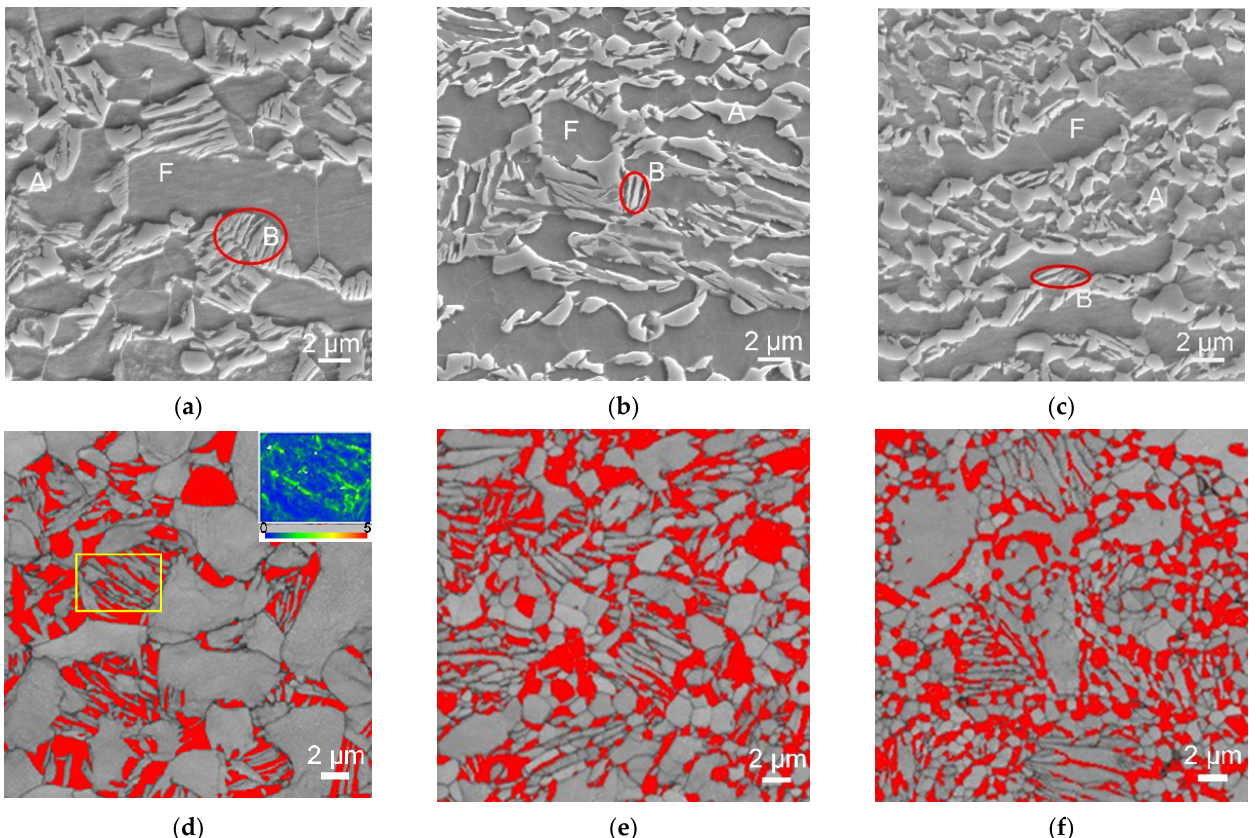
Figure 4. The microstructure observation by scanning electron microscope (SEM) ( a – c ) and electron backscattered diffraction (EBSD) ( d – f ) on three experimental steels treated by process 2. ( a , d ) 1 Mn steel; ( b , e ) 1.5 Mn steel; ( c , f ) 2 Mn steel. F, A, and B in ( a – c ) represent ferrite, austenite, and bainite; the red regions in ( c – f ) show austenite phase. The inserted image in ( d ) is the kernel average misorientation (KAM) map of the yellow rectangle